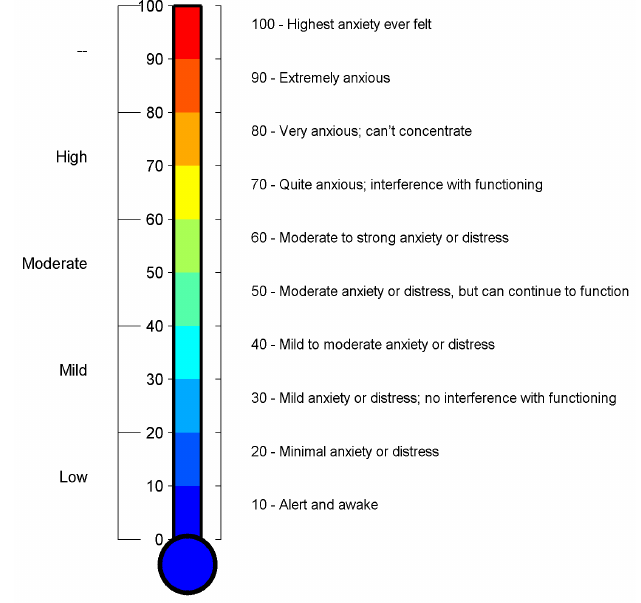
Figure 5. Anxiety level class assignment by Subjective Units of Distress Scale (SUDS) value.